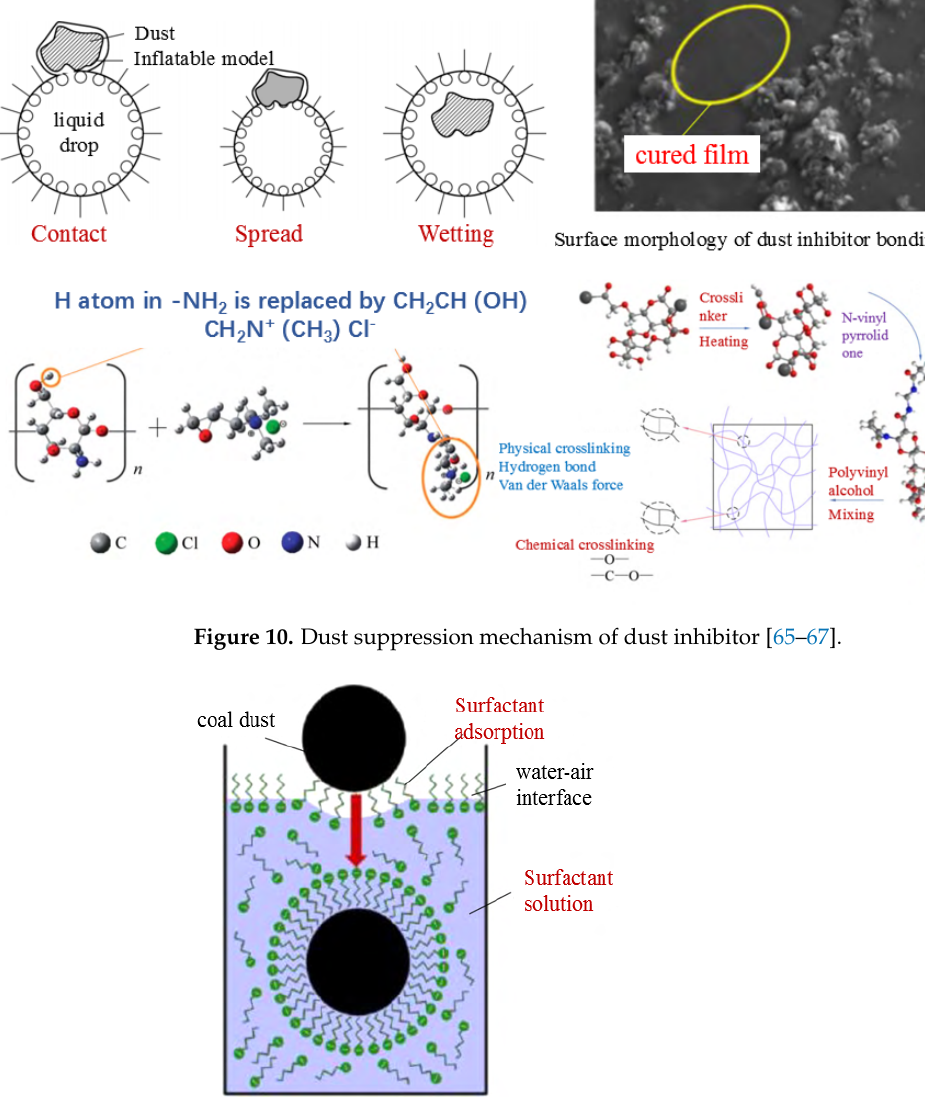
Figure 11. Dynamic wetting process of coal dust [69].